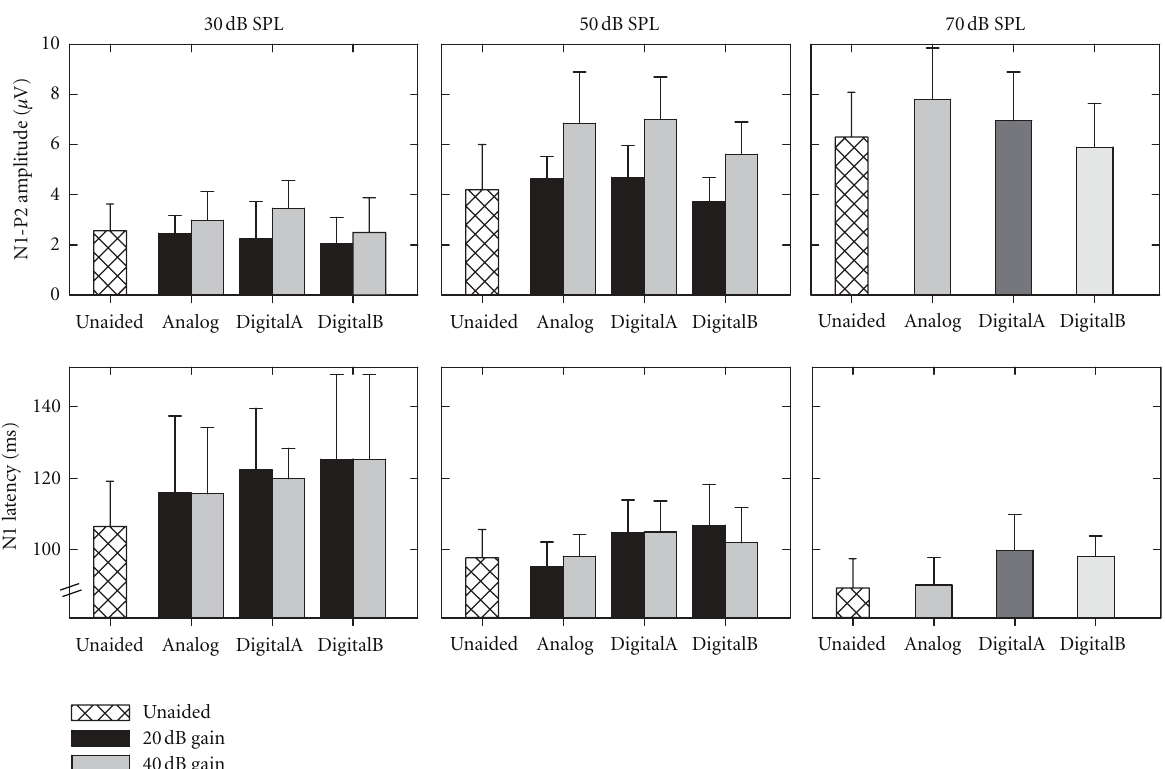
Figure 2: Mean and SD amplitude and latency data for unaided and aided conditions (Analog, DigitalA, and DigitalB) with two gain settings (20 and 40dB) at three input levels (30, 50 and 70dB SPL). Sample size is N = 13 for all conditions, except for the following latency results: 30dB SPL/DigitalA/20 dB gain ( N = 10); 30dB SPL/DigitalB/20 dB gain ( N = 11); 30 dB SPL/DigitalB/40dB gain ( N =